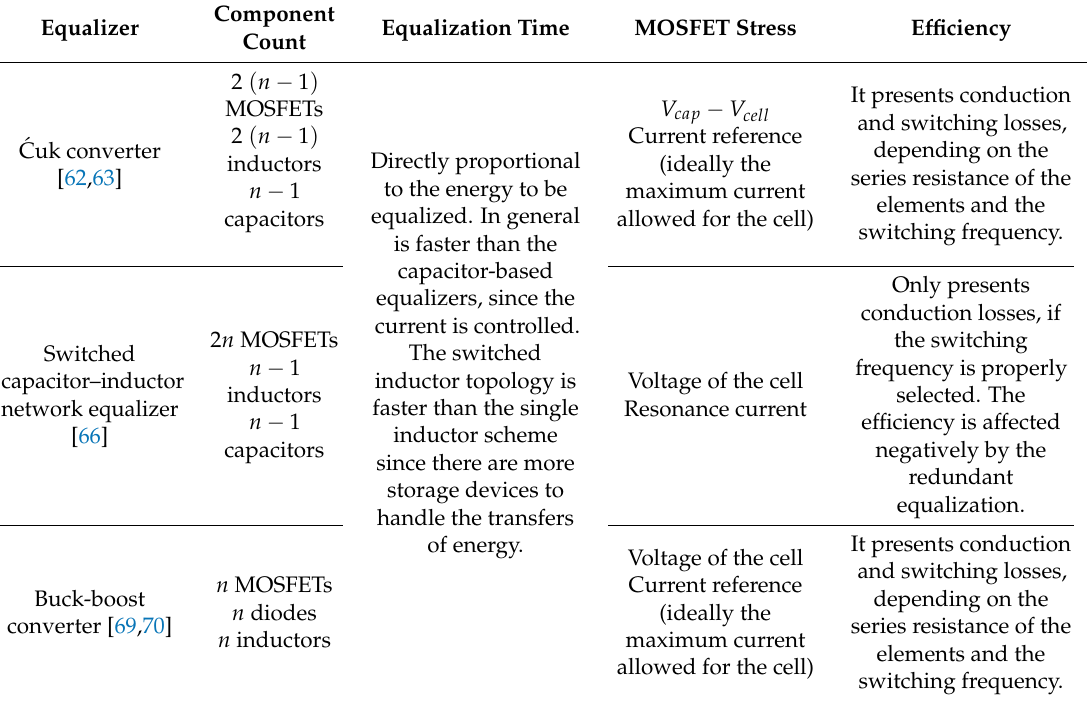
Table 5. Comparative analysis of converter-based